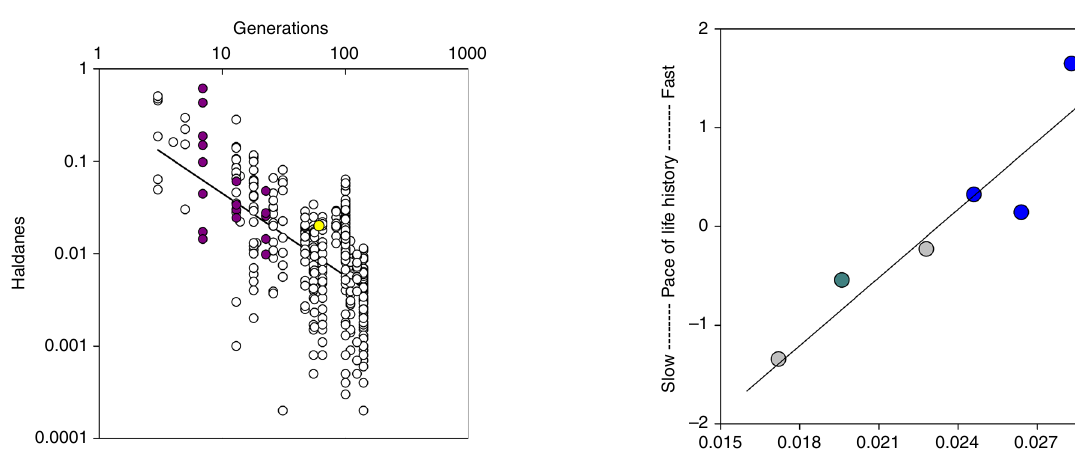
Fig. 2 Rates of evolution are slower when measured over longer time intervals. Rates, plotted in haldanes (standard deviations of change per generation), are shown for metabolic rate in guppies from the El Cedro River from this study (yellow, n = 1), previously published estimates for guppy life history traits from the El Cedro River (purple, n = 18) 30 , and previously published estimates for life history and morphological traits of other taxa (white, n = 402) 30 . All estimates are absolute values of haldanes derived from common garden or quantitative-genetic methods. Note the logarithmic scale on both axes